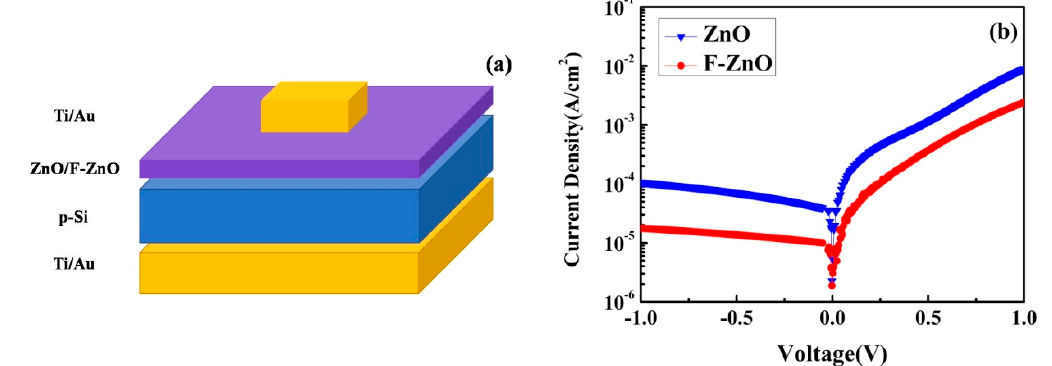
Figure 7. ( a ) ZnO/p-Si heterojunction diode and ( b ) the J–V curve of ZnO/p-Si heterojunction diode Figure 7. ( a ) ZnO / p-Si heterojunction diode and ( b ) the J–V curve of ZnO / p-Si heterojunction diode with and without SF 6 plasma treatment. with and without SF 6 plasma